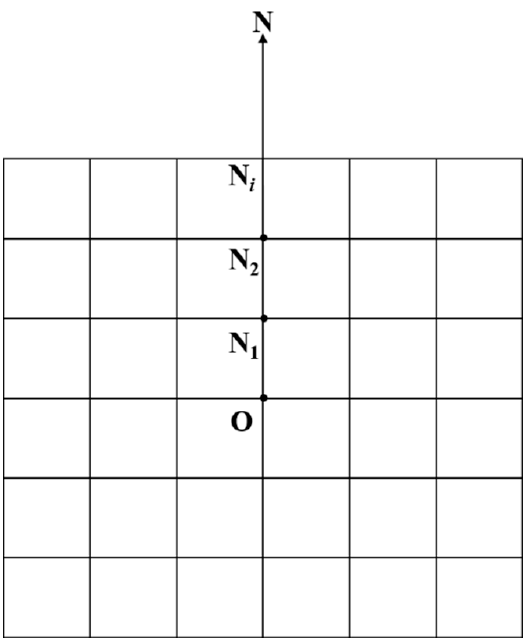
Figure 4. The situation of target points in the N direction.